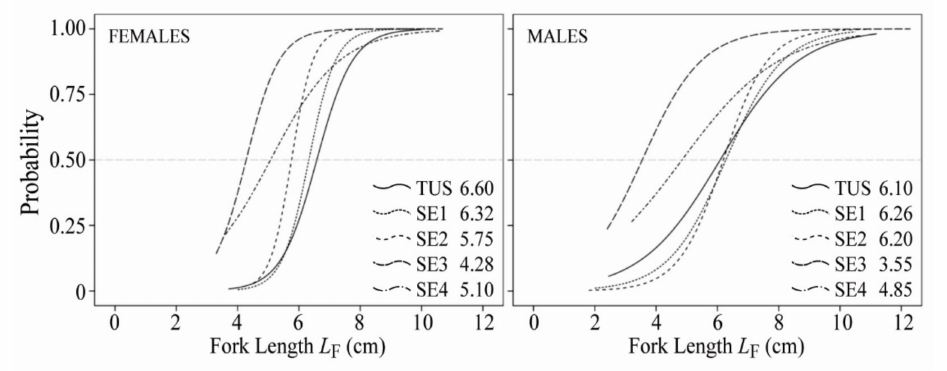
Figure 4. Predicted probability of maturity according to fork length for females and males for the five studied populations (TUS, SE1, SE2, SE3 and SE4) of Gobio lozanoi . Oocytes larger than 0.25 mm in diameter were considered opaque and all oocytes above 0.55 mm of diameter were vitellogenic. Fecundity data from each sampling site are summarised in Table 3. No significant differences were found in fecundity and oocyte diam- eters by age (ANCOVA, p > 0.05) and fork length was not significant as a covariable when oocyte diameters were analysed, which indicates no effect of fish size on egg diameters in the studied fish. Significant differences were found in potential (ANCOVA F (1, 4, 39) = 3.27, p = 0.023) and absolute fecundity (ANCOVA F (1, 4, 39) = 2.90, p = 0.037) among sampling sites. SE1 showed the highest number of oocytes and SE3 showed the lowest ones at a given length (Bonferroni post hoc: p = 0.023 and p = 0.037, respectively). Only the